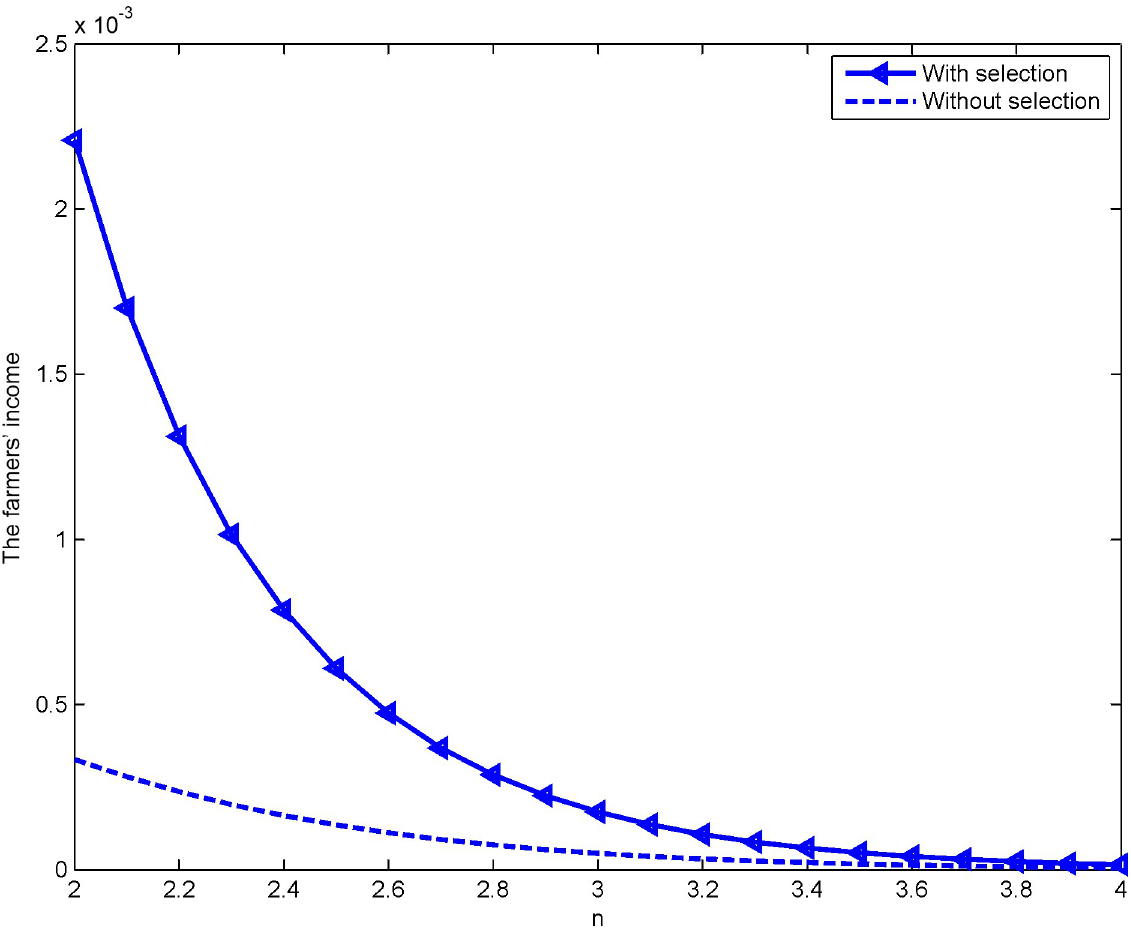
Fig 4. Impact of n on farmers’ income for the first-price sealed-bid